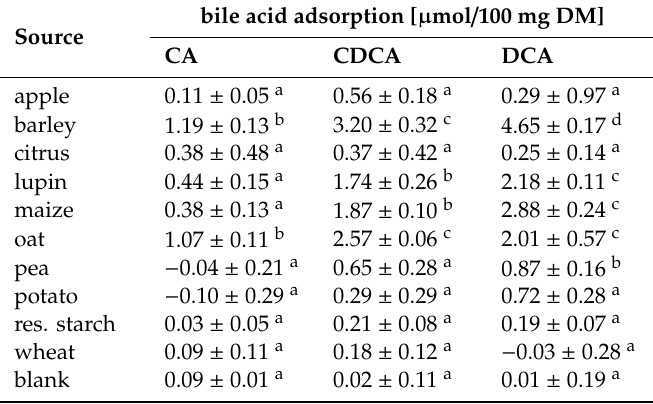
Table 2. Bile acid adsorption of dietary fibre enriched food ingredients (given as sum of glyco- and tauroconjugated cholic acids (CA), chenodesoxycholic acids (CDCA), desoxycholic acids (DCA)).